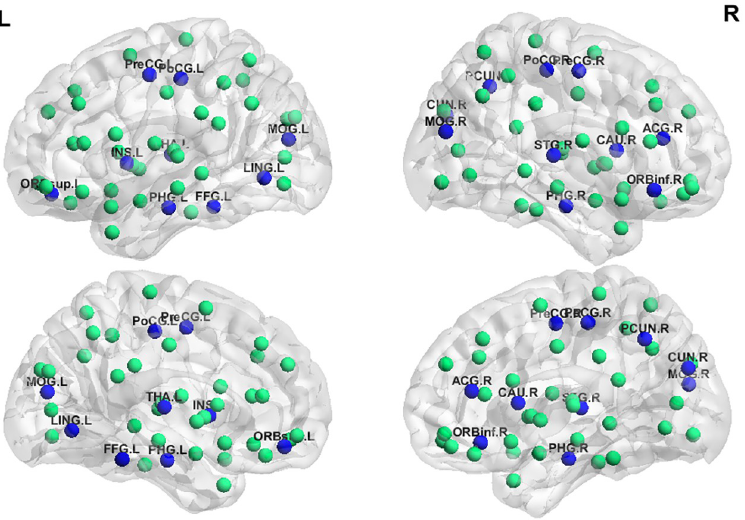
Fig 1. A general block diagram of the proposed schizophrenia detection schemes. The single-feature-type schemes follow the red arrows. The feature-fusion schemes are indicated by the blue arrows. For the decision-level fusion schemes, the orange arrows trace the path from the single-feature-type schemes to the final fused